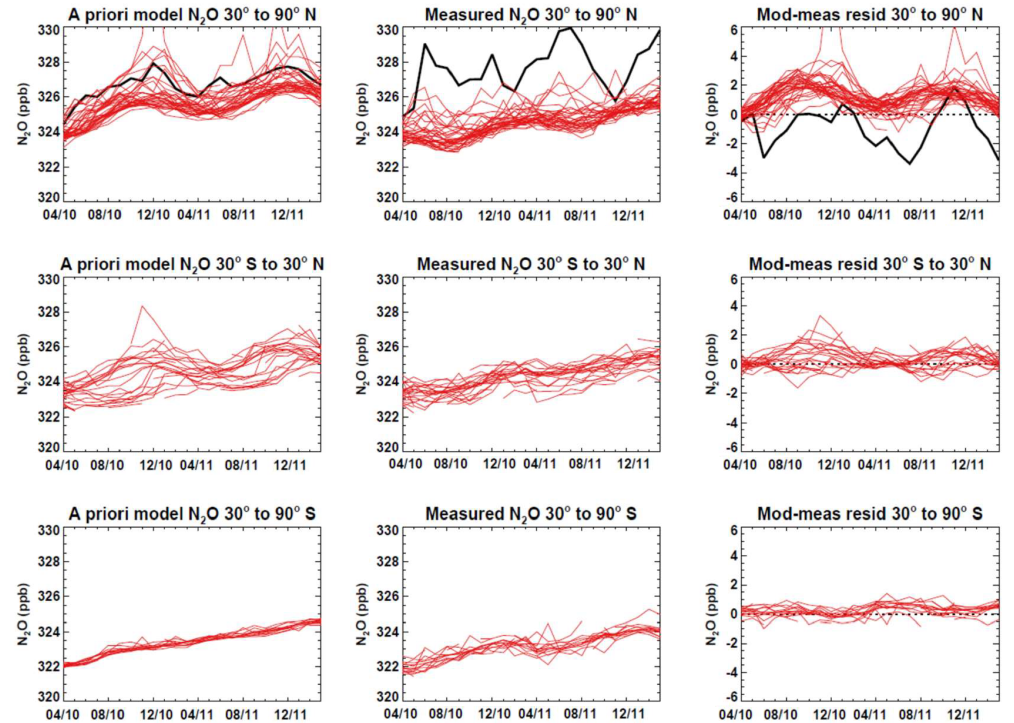
Figure 6. Two-year timelines of monthly-averaged a priori modeled and measured N 2 O mixing ratios, and the resulting model–measurement residuals, for individual measurement sites as a function of latitude. The solid black line in the top panels shows results for the KCMP tall tower site in MN, USA.